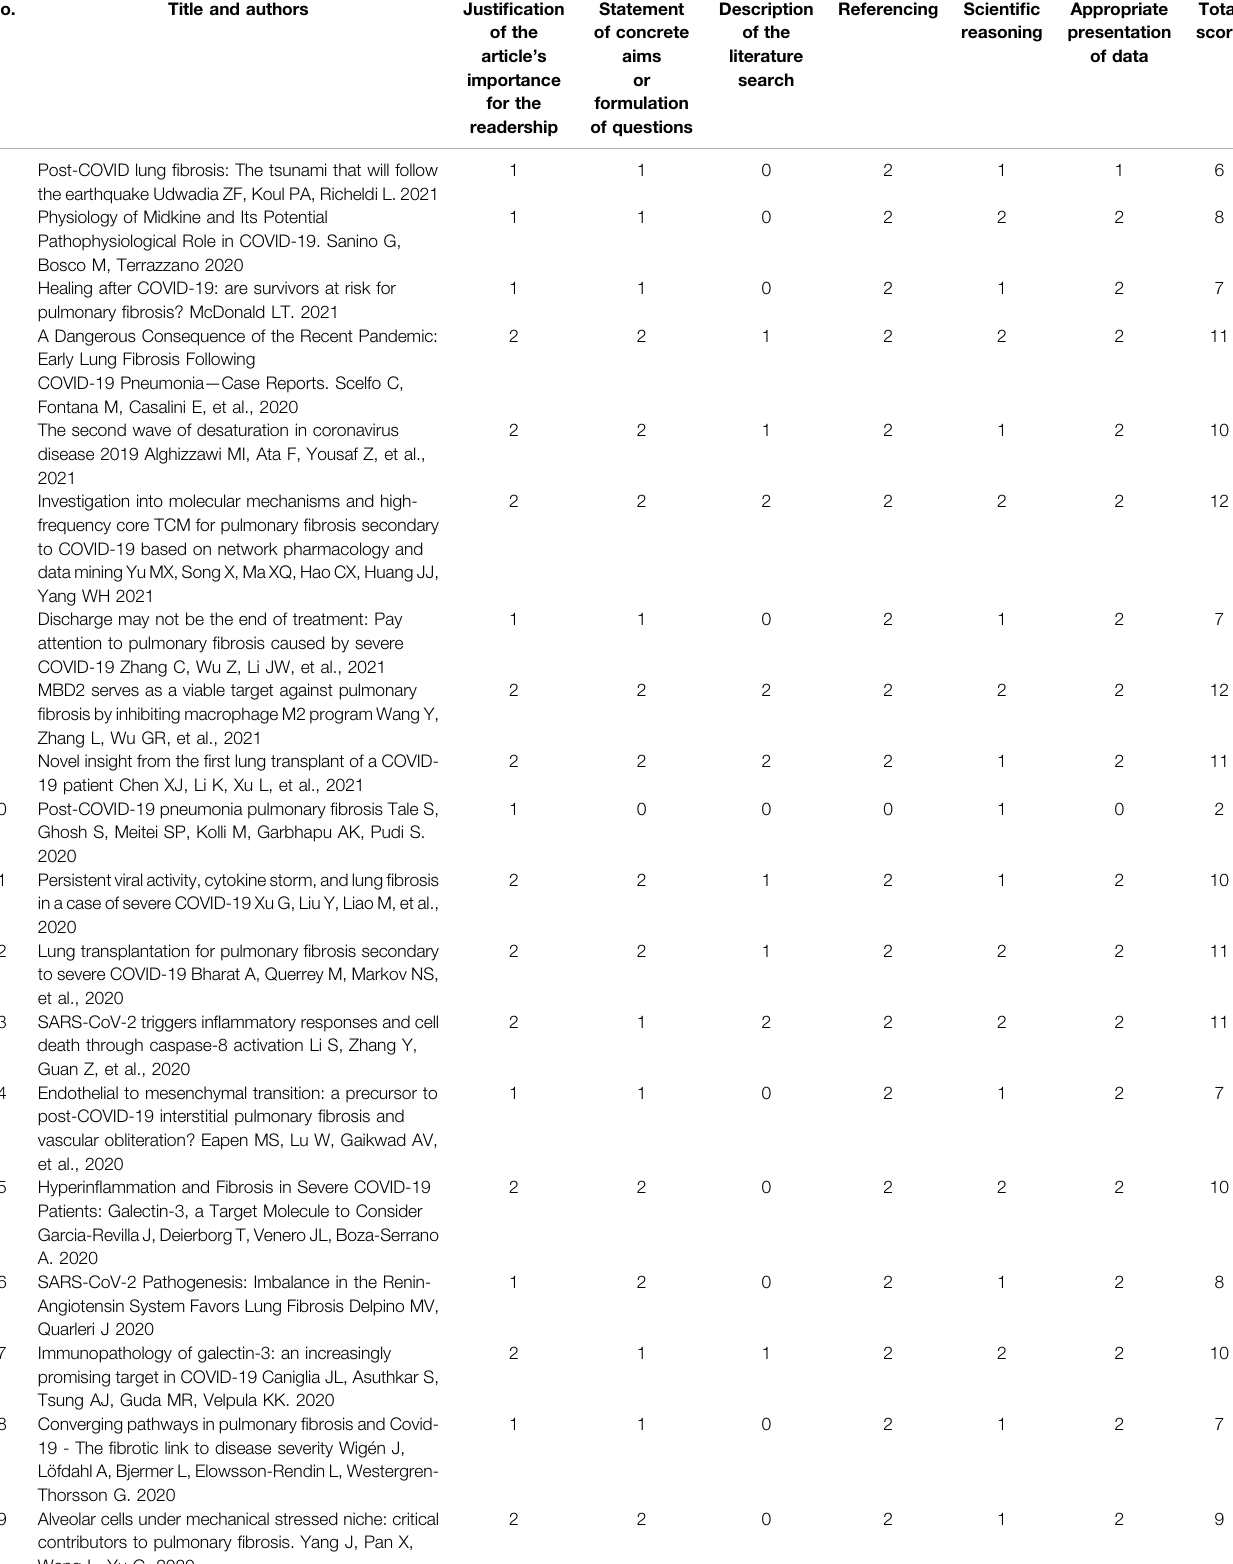
TABLE 1 | SANRA Score for quality